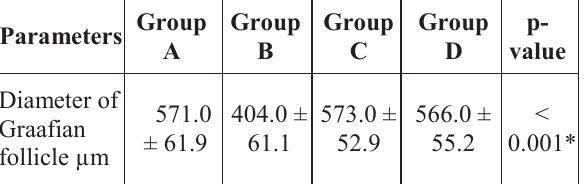
Table-6: Comparison of diameter of Graafian follicle among groups based on one way